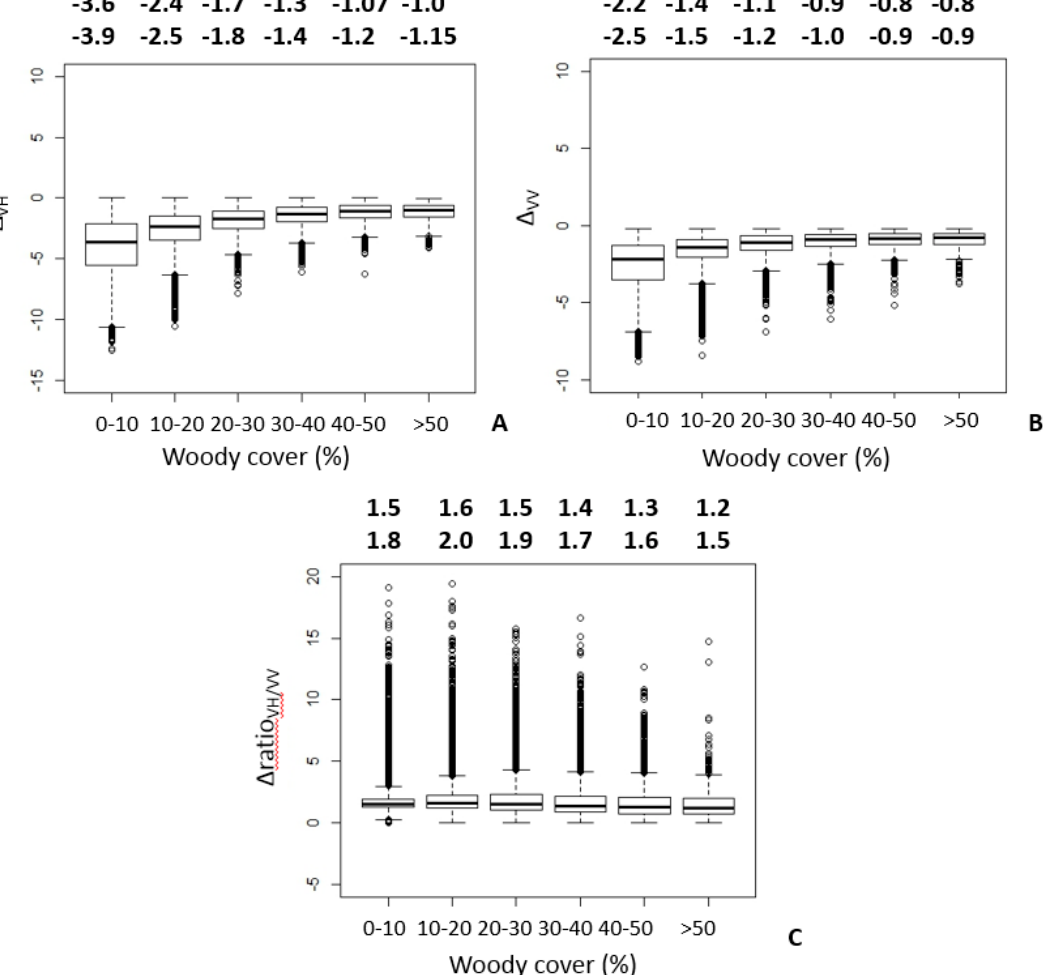
Figure 11. Quartile box-plots comparing the pre-fire to post-fire backscatter di ff erences ( A ) ∆ VH , ( B ) ∆ VV , and the cross- and polarized ratio ( C ) ∆ ratio VH / VV calculated within individual 1 ha pixels (100,000 + pixels across the 30 burn events) as a function of woody canopy cover quantized into 10% ranges. Plain bold lines indicate the median, and the median (top line) and mean (bottom line) values are given at the top of each graph.